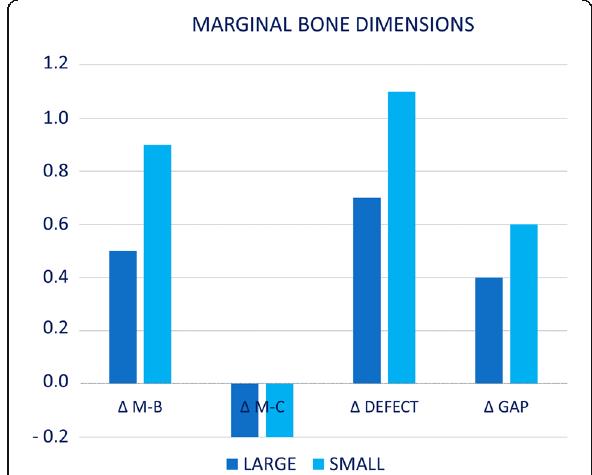
Fig. 4 Graphs illustrating the radiographic change at the marginal bone 5 months after treatment. Mean gain of osseointegration and closure of the defect were observed in both